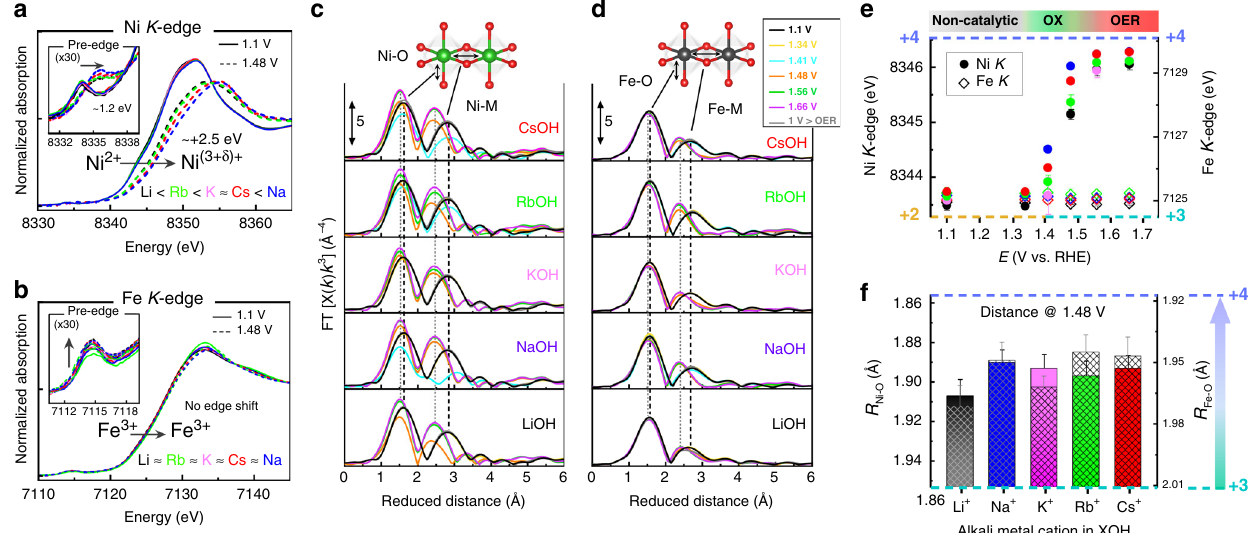
Fig. 3 In situ X-ray absorption spectroscopy in presence of alkali metal cations. In situ XAS was performed at the Ni and Fe K -edges of the Ni 65 Fe 35 (OOH) catalyst in puri fi ed 0.1 M XOH electrolytes (X = Li + , Na + , K + , Rb + , Cs + ). a Ni XANES at 1.1 V (solid curves) and at 1.48 V (dashed curves). The inset shows an enlargement of the pre-edge region and the arrow indicates the direction of change upon oxidizing potential. b Fe XANES at 1.1 V (solid curves) and at 1.48 V (dashed curves). The inset shows an enlargement of the pre-edge region with the direction of change indicated by the arrow. c The k 3 -weighted FT-EXAFS at the Ni K -edges. d The k 3 -weighted FT-EXAFS at the Fe K -edges. e Ni and Fe K -edge positions vs. the applied potential. The colored areas on top indicate the different regions (non-catalytic, oxidative “ OX ” , and “ OER ” catalytic). f Trend-plots of the Ni – O and Fe – O coordination distances at 1.48 V vs. the alkali metal cation (X) in the XOH electrolyte. Oxidation states are indicated in e and f with following colors: + 2 (yellow), + 3 (green), and + 4 (purple). Error bars show the standard error from the overall number of